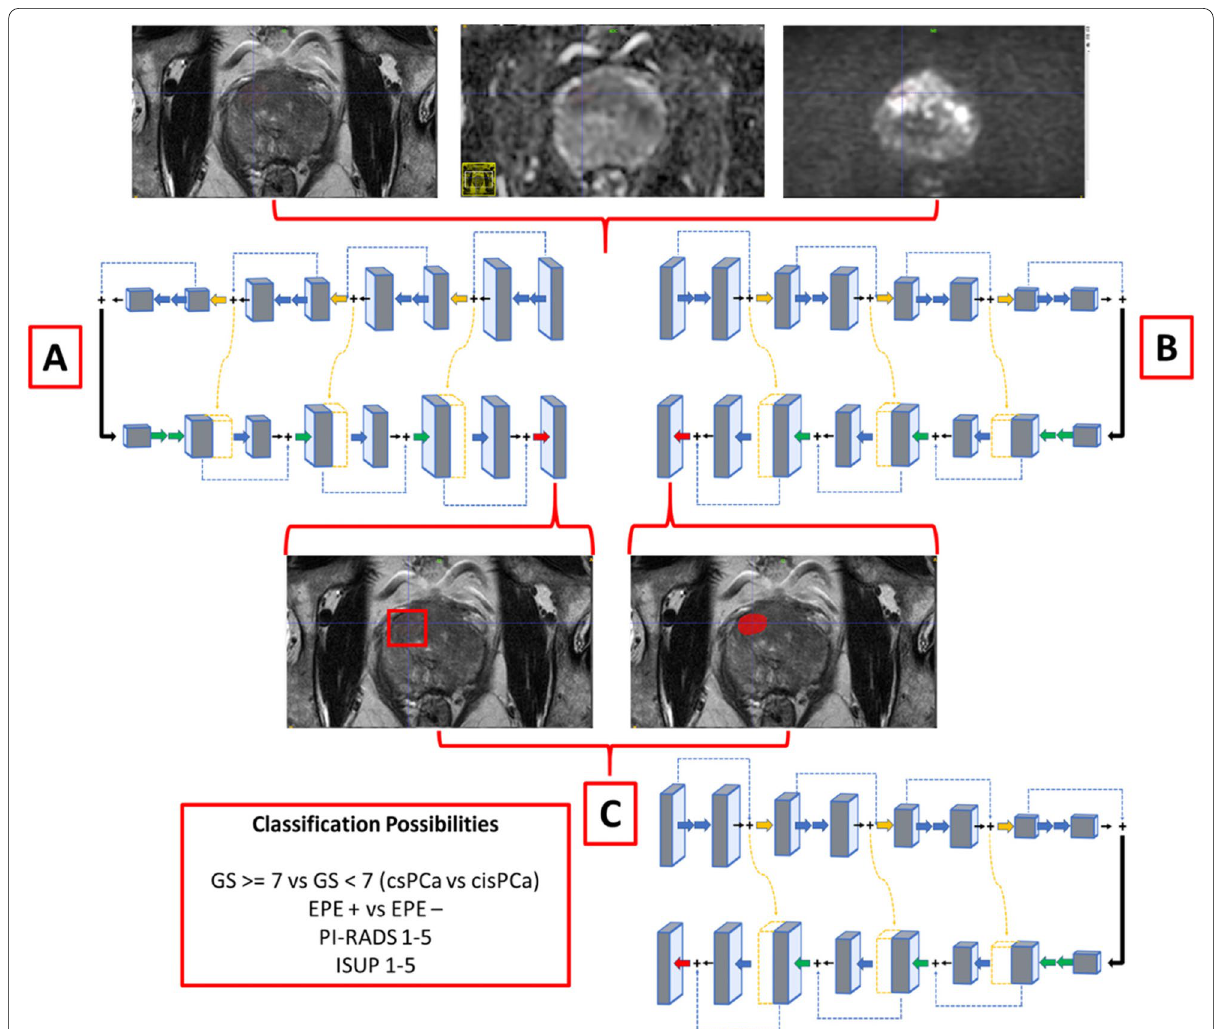
Fig. 1 Example of potential artificial intelligence outputs from combining the three sequences of multi-parametric magnetic resonance imaging, with ( A ) representing the detection arm identifying the bounding box, ( B ) representing the lesion segmentation arm, and ( C ) representing the classification arm with the ability to classify lesions from pre-annotated bounding boxes, lesion segmentations, or full non-annotated images. EPE Extra-prostatic extension, GS Gleason score, ISUP International Society of Urological Pathology, PI-RADS Prostate Imaging Reporting and Data